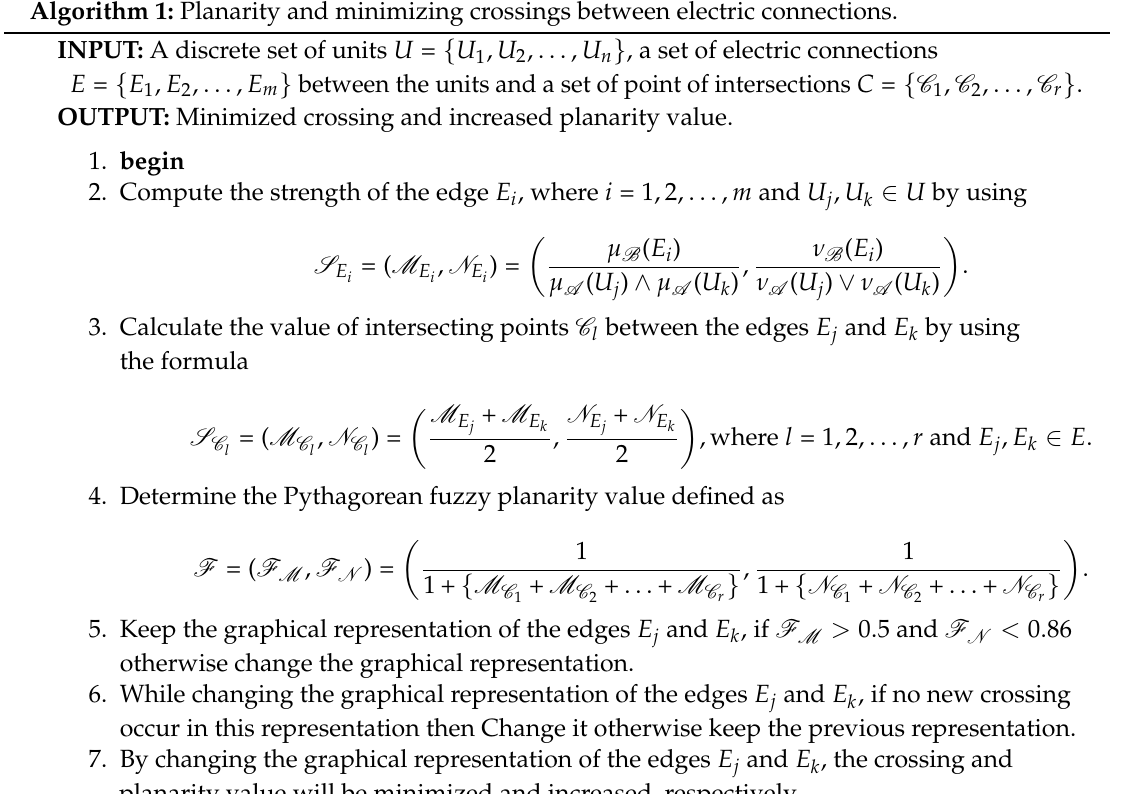
Algorithm 1: Planarity and minimizing crossings between electric